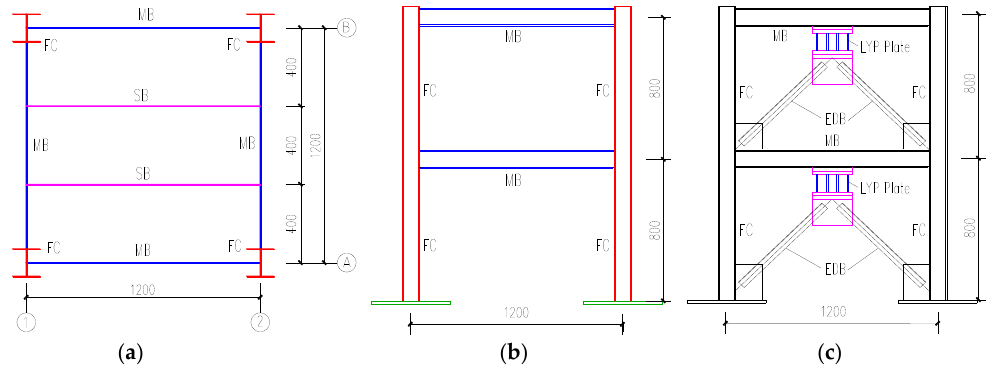
Figure 1. Specimen size (unit: mm). ( a ) Plane layout; ( b ) elevation at first or second axis; ( c ) elevation at A or B axis.